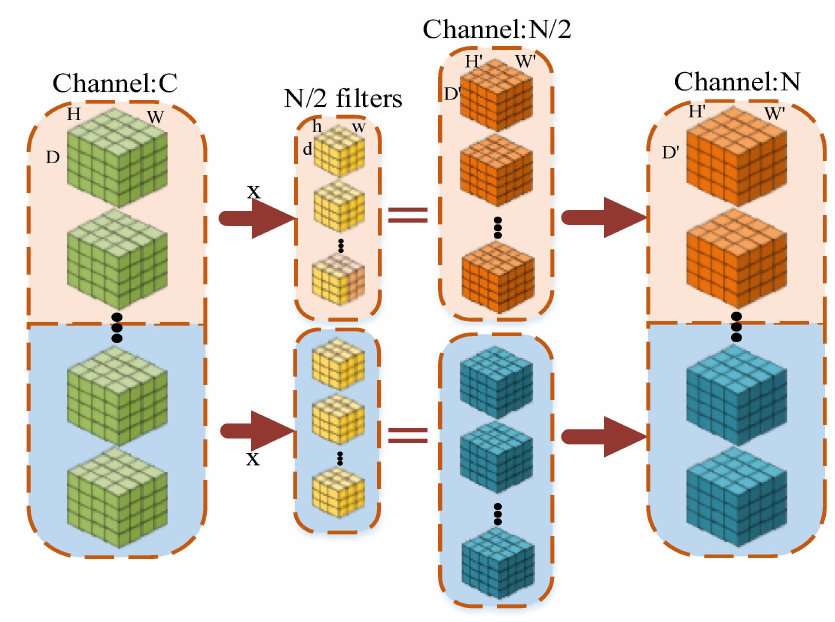
Figure 5. Group convolution diagram when the number of groups was